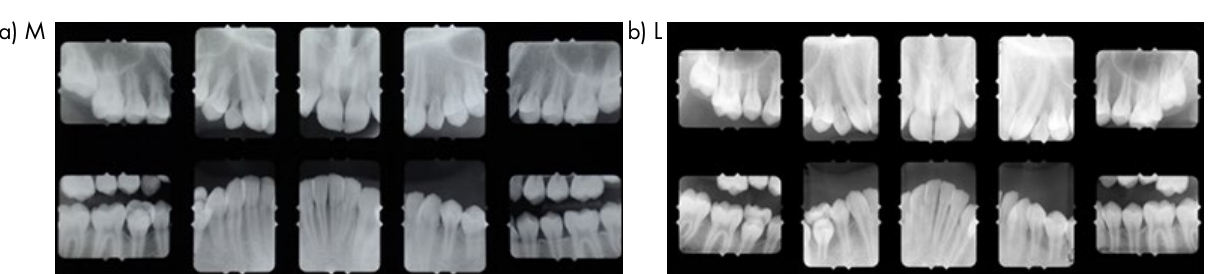
Figure 4. Pretreatment periapical